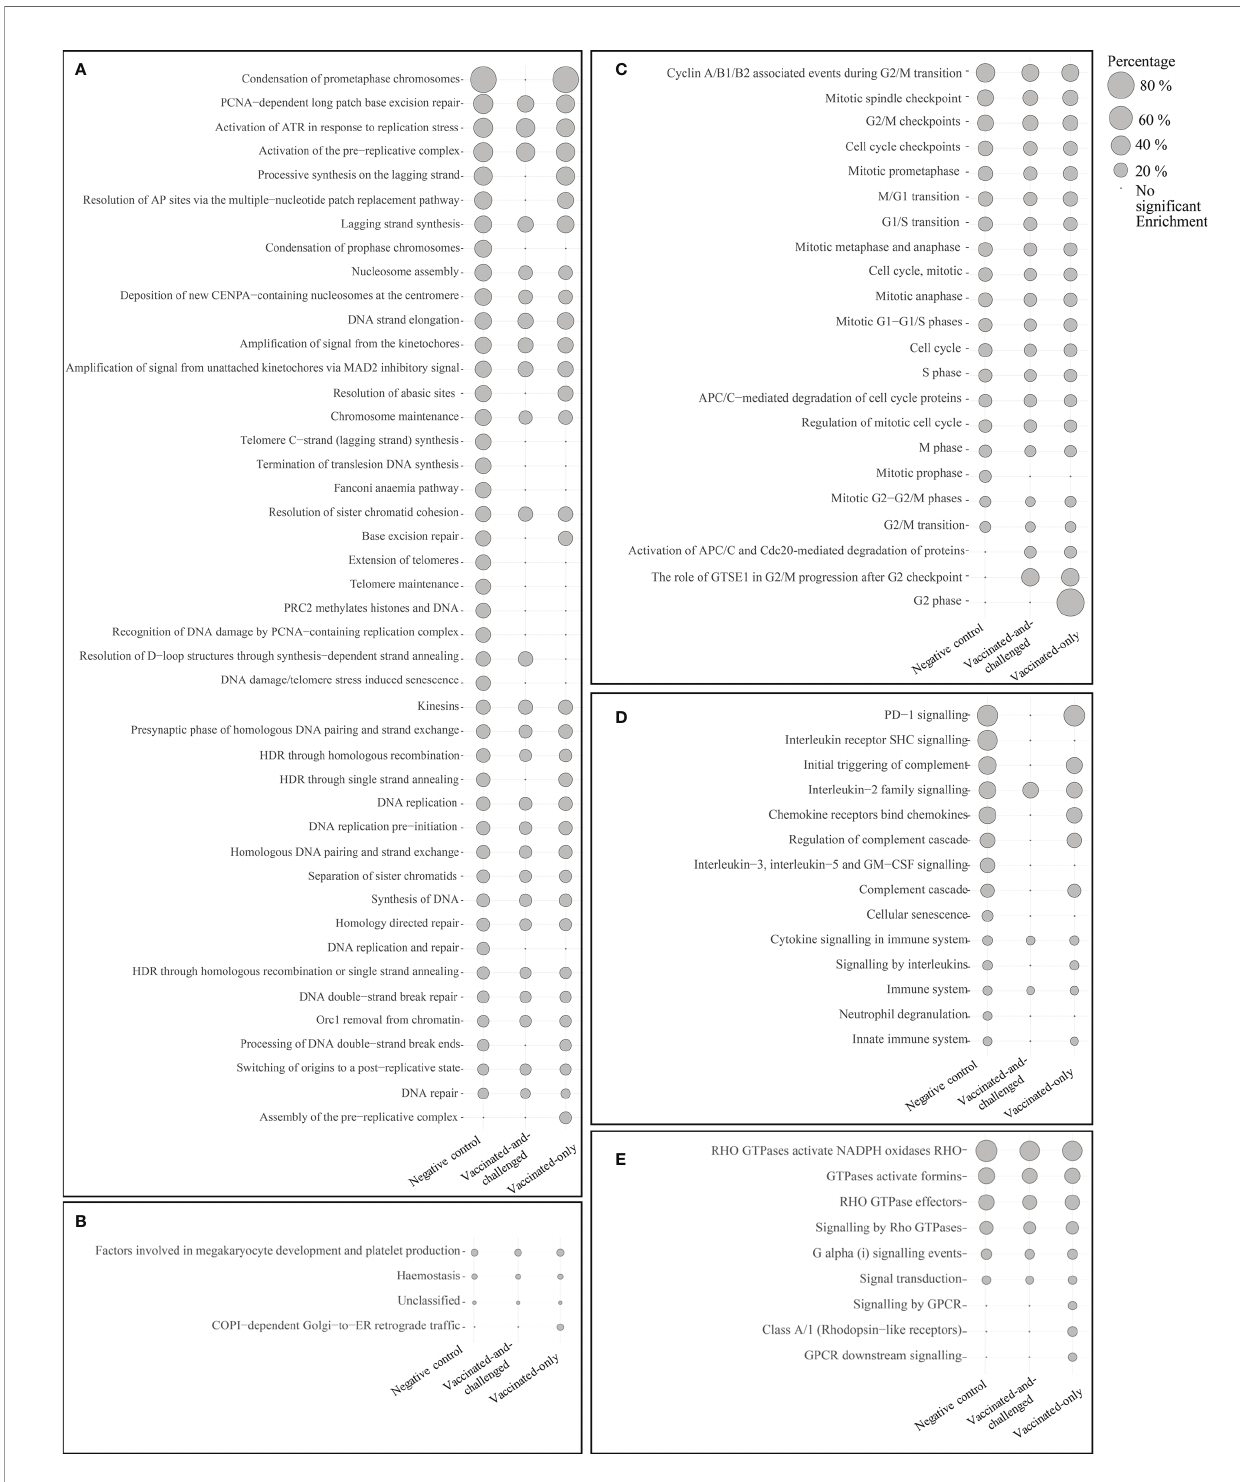
FIGURE 3 | Reactome pathways enriched with up-regulated genes in the challenged-only group compared to the negative control, vaccinated-and-challenged or vaccinated-only group. (A) Pathways involved in DNA replication, (B) other pathways, (C) pathways involved in the cell cycle (mitosis), (D) pathways involved in immune responses, (E) pathways involved in signal transduction. Grey solid circles indicate the proportion of up-regulated genes out of the total number of genes in each pathway. The pathways are listed in order of decreasing proportions in the negative control group. A false discovery rate (FDR) of < 0.01 was considered signi fi